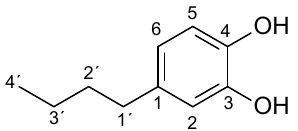
Figure A4. 4- n -butylcatechol ( 4b ). 1 H NMR (399.87 MHz, DMSO- d 6 , 30 °C): 0.873 (3H, t, J = 7.3 Hz, H-4 ′ ), 1.270 (2H, m, H-3 ′ ), 1.468 (2H, m, H-2 ′ ), 2.388 (2H, m, H-1 ′ ), 6.407 (1H, dd, J = 8.0, 2.1 Hz, H-6), 6.560 (1H, d, J = 2.1 Hz, H-2), 6.621 (1H, d, J = 8.0 Hz, H-5), 8.563 (2H, br s, 3,4-OH). 13 C NMR (100.55 MHz, DMSO- d 6 , 30 °C): 13.73 (C-4 ′ ), 21.64 (C-3 ′ ), 33.37 (C-2 ′ ), 34.16 (C-1 ′ ), 115.34 (C-5), 115.61 (C-2), 118.76 (C-6), 133.09 (C-1), 142.98 (C-4), 144.89 (C-3). OH